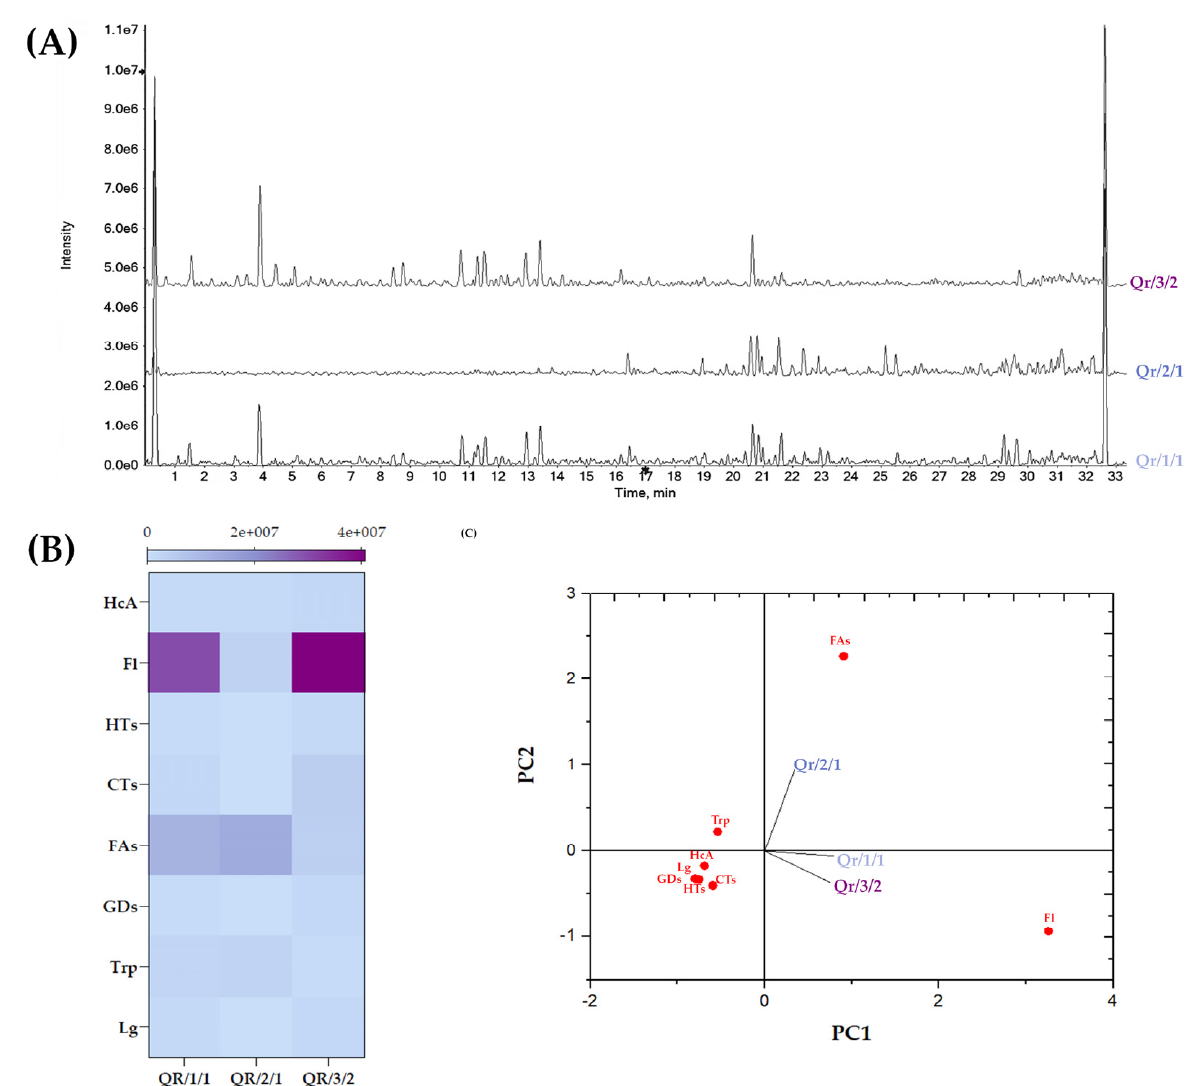
Figure 3. ( A ) Total ion current (TIC) chromatograms of Qr/1/1 extract, Qr/2/1 fraction and Qr/3/2 fraction. ( B ) Heatmap of the relative content of each extract/fraction in derivatives of gallic acids (GDs), hydroxycinnamic acid (HcA), lignans (Lg) as well as flavonoids (Fl), hydrolysable (HTs) and condensed tannins (CTs), fatty acids (FAs) and triterpenes (Trp), is shown. Principal component analysis is on the left, based on different classes of identified compounds with PC1% variance = 68.5 and PC2% variance = 31.5. Quinic acid ( 1 ), gallic acid ( 3 ) and two isomers of gallic acid hexoside ([M − H] − at m / z 331.0676(57); ( 2 , 4 ) were identified in the alcoholic extract and Qr/3/2 fraction, together with hydrolysable (HTs) and condensed (CTs) tannins, whose structures are schematized in Table